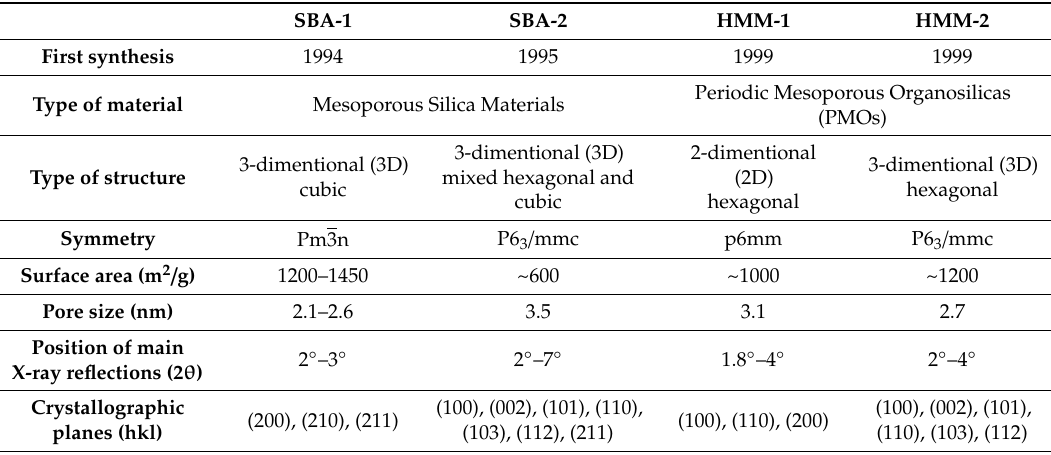
Table 1. Comparison of SBA and HMM materials.